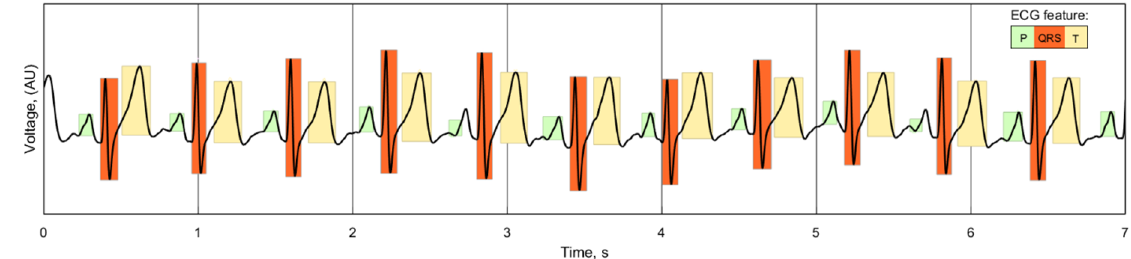
Figure 16. Wavelet delineation of a 7 s sample of recorded ECG, showing the location and duration of the waveform features.